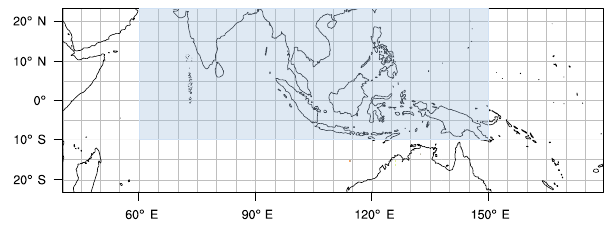
Figure 1. Model domain used for simulations. The blue color re- gion indicates the fossil fuel emission coverage from the Regional Emission inventory in ASia (REAS). The rest of the domain uses the fossil fuel emission from the Emissions Database for Global At- mospheric Research